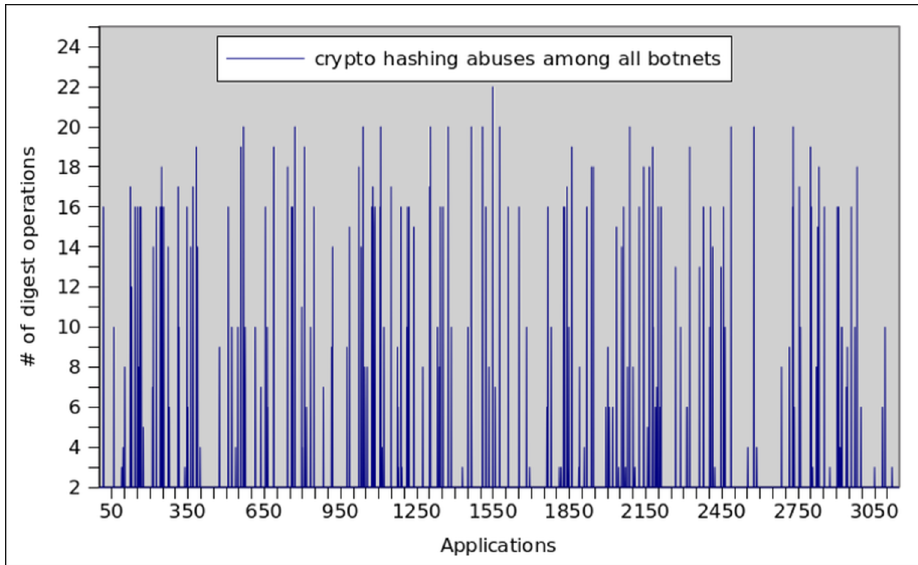
Fig 11. Message digest operations misused by Botnet